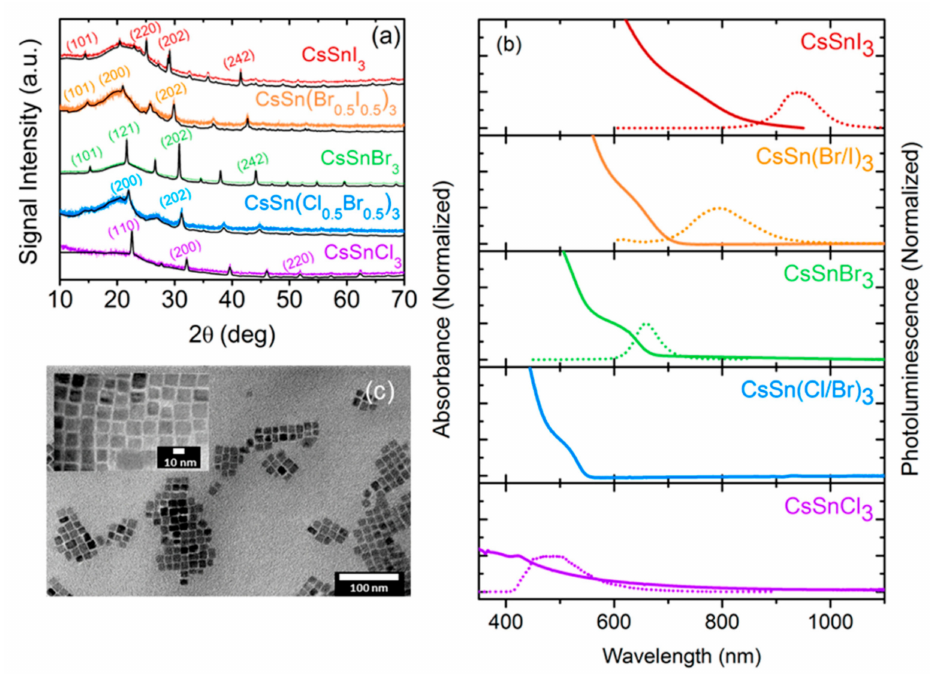
Figure 7. ( a ) Powder X-ray diffraction spectra of CsSnX 3 (X = Cl, Cl 0.5 Br 0.5 , Br, Br 0.5 I 0.5 , I)